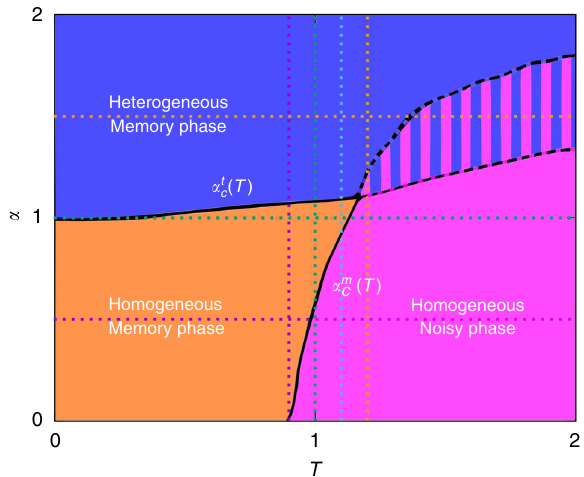
Fig. 4 Phase diagram. Phase diagram as obtained from analysis of the control parameters ( m , g and r ) as de fi ned in the main text. The transition lines, corresponding to α t T Þ and α m T Þ as labelled, are indicated either c ð c ð with solid or dashed lines regarding whether they correspond to continuous or discontinuous transitions. The horizontal and vertical dotted lines correspond to the cases illustrated in Fig. 3. Parameters as in Fig. 3. Data points are averaged over 10